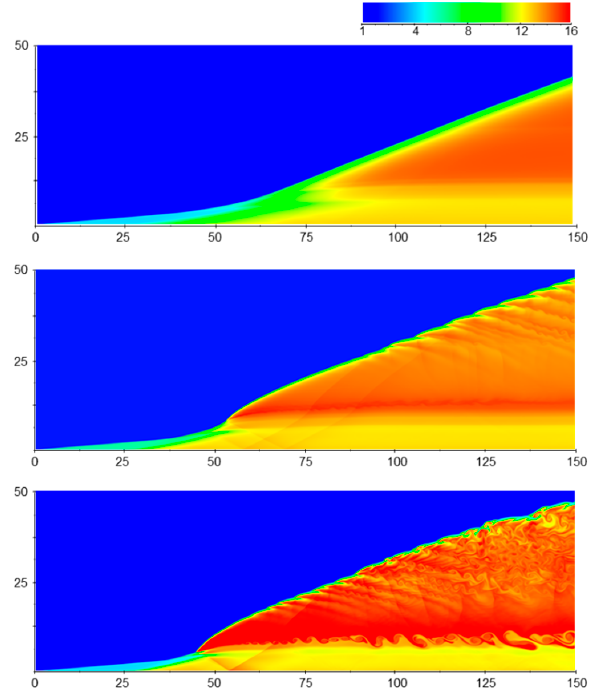
Figure 9. Temperature contours with M 0 = 10 and θ = 30° for k R = 1.0 (upper); 2.98 (middle); and 5.0 (lower).